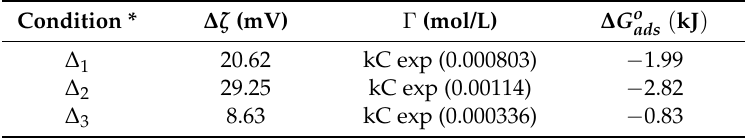
Figure 3. The percentage distribution of SPA species as a function of aqueous pH values, K α 1 = 2.0; K α 2 = 7.1 [43]. Table 2. The results of different parameters at pH 2.7 under various conditions.